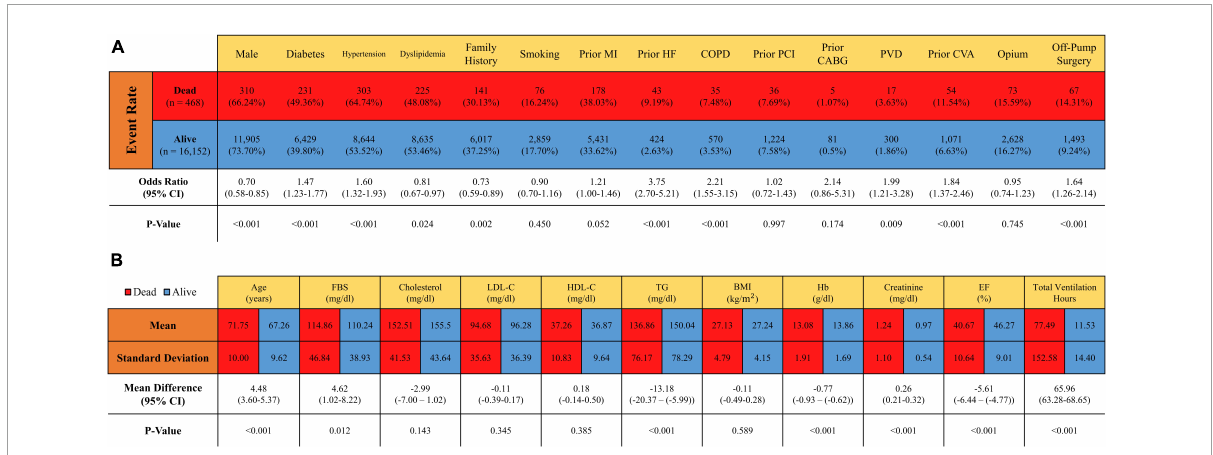
FIGURE2 Comparison of baseline and hospitalization characteristics of survivors and non-survivors with one-year follow-up. MI, myocardial infarction; HF, heart failure; COPD, chronic obstructive pulmonary disease; CABG, coronary artery bypass grafting; PCI, primary cutaneous intervention; PVD, peripheral vascular disease; CVA, cerebrovascular accident; FBS, fasting blood glucose; LDL-C, low-density lipoprotein cholesterol; HDL-C, high-density lipoprotein cholesterol; TG, triglyceride; BMI, body mass index; Hb, hemoglobin; EF, ejection fraction.